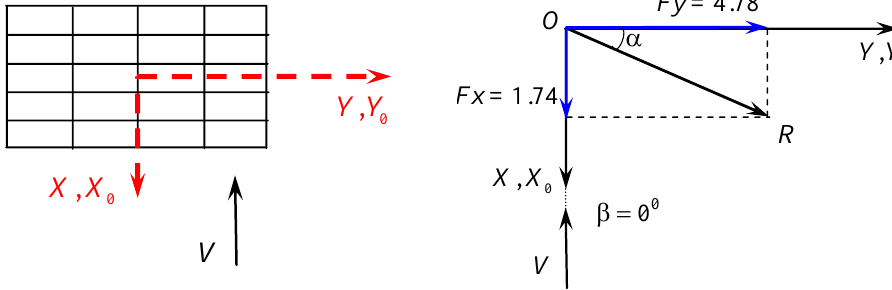
Figure 12. Direction of forces in the section at the angle of attack β = 0 ◦ .